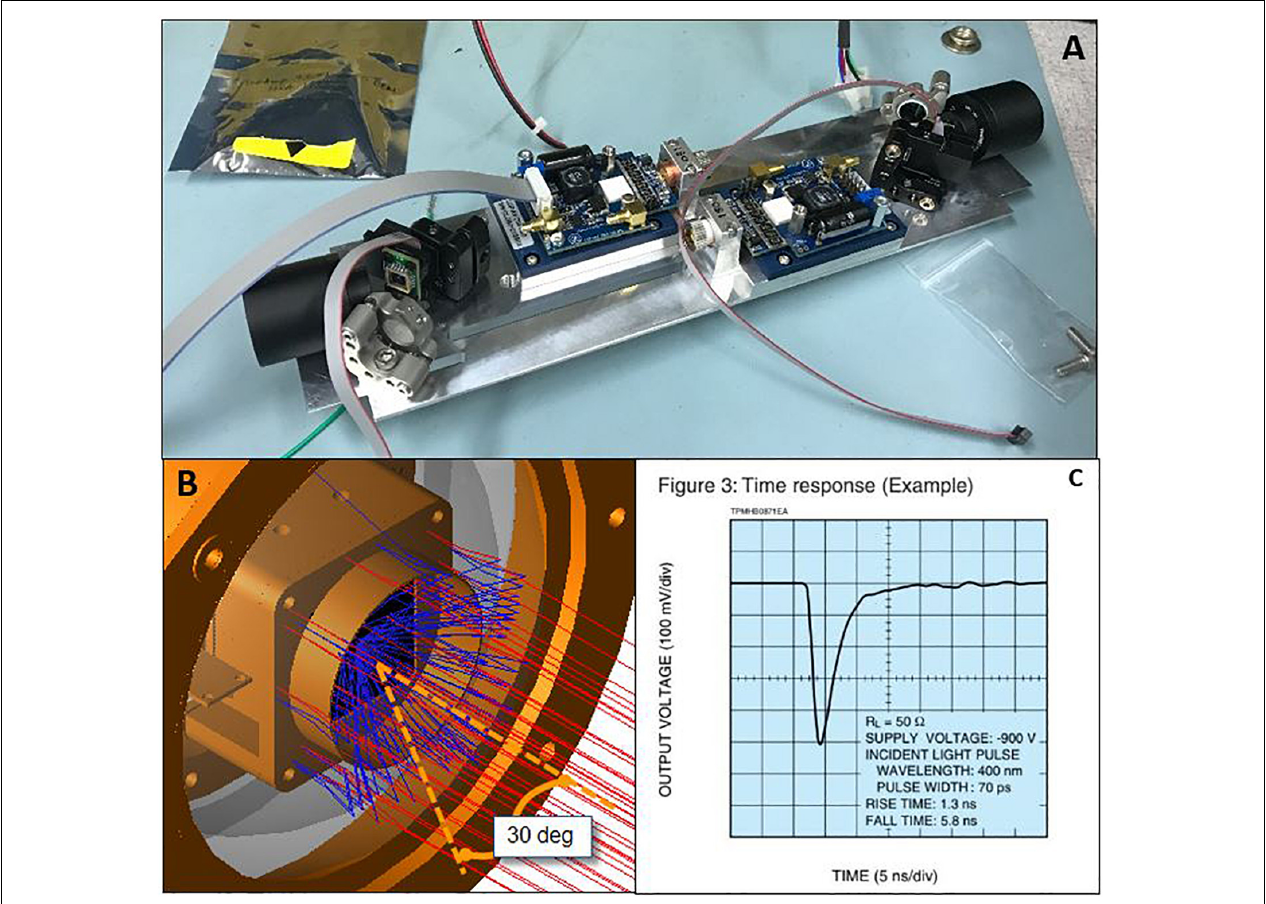
FIGURE 1 | (A) Inside components of the transmitter with DMD device for laser scanning array. (B) Represents a ray-trace of the PMT array with acceptance angle shield. (C) Rise and fall time of PMT.